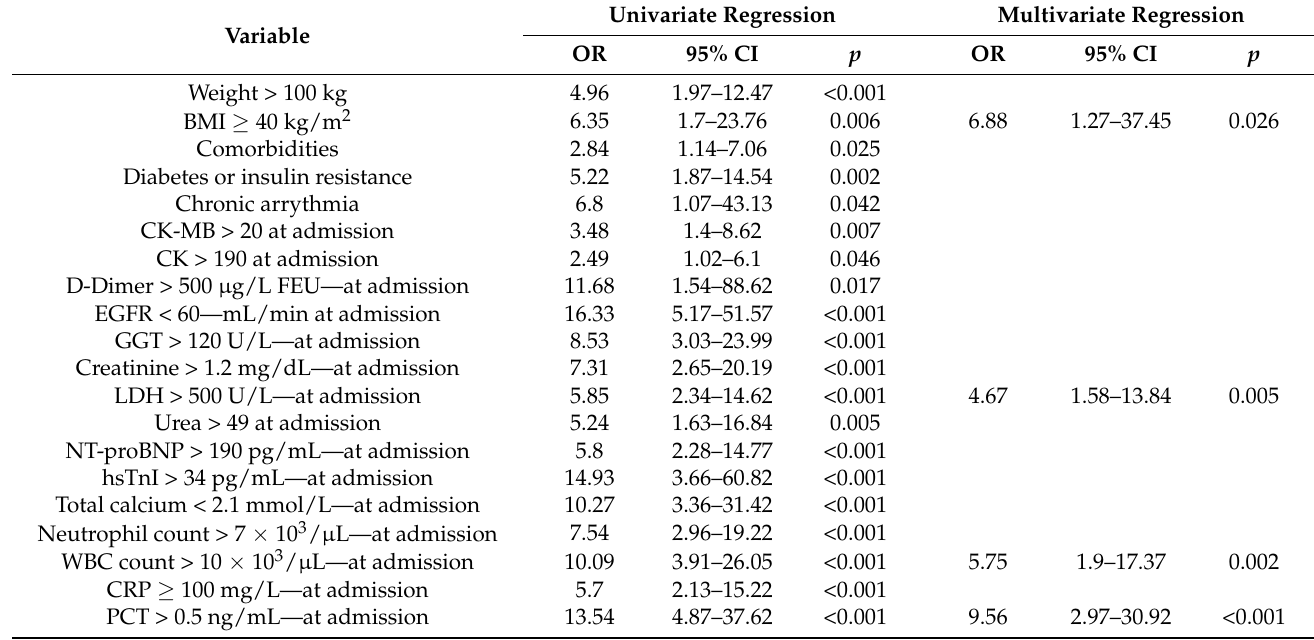
Table 9. Univariate and multivariate logistic regression analysis of selected clinical characteristics and laboratory parameters at admission for the prediction of mechanical ventilation.